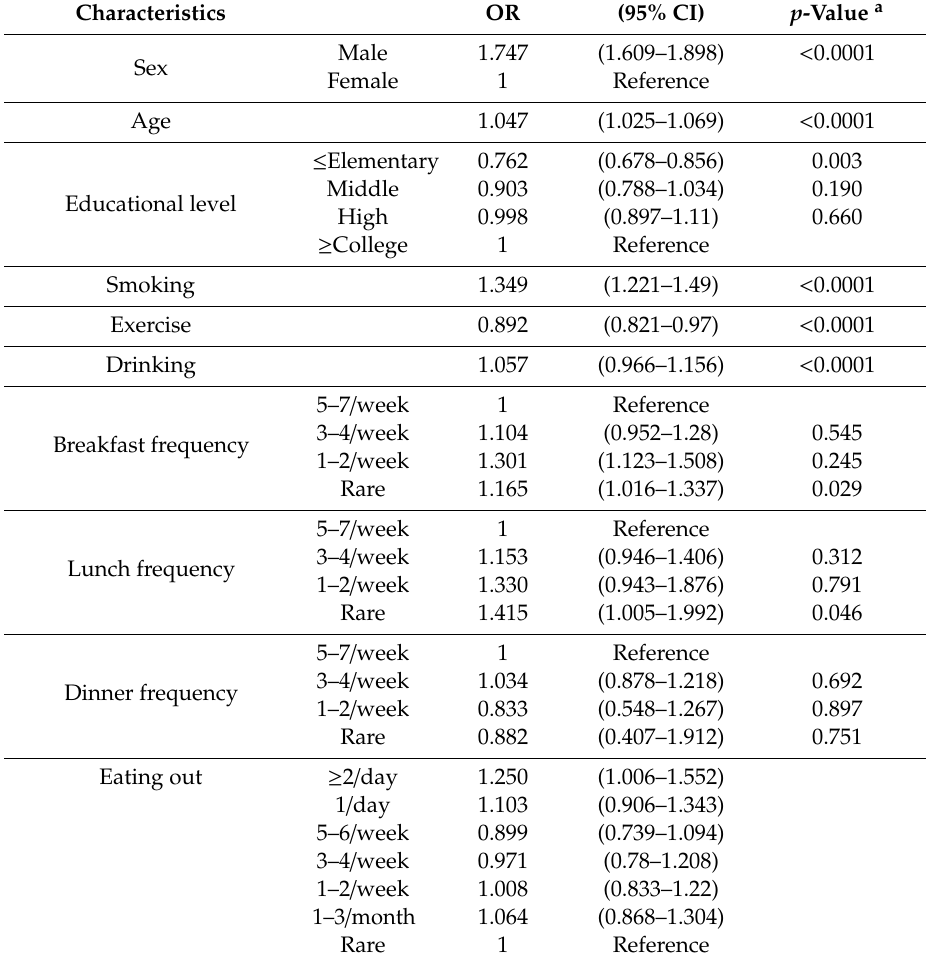
Table 2. General characteristics and the association between NAFLD and dietary habits, stress, and